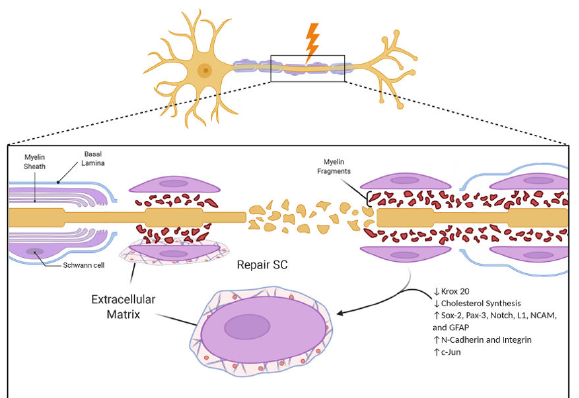
Figure 1. The loss of contact with the axon activates morpho-functional changes leading to the repair Schwann cells (SCs). The figure was adapted from “Peripheral Nervous System (PNS) Myelin Structure” by BioRender.com (2020). GFAP, Glial fibrillary acidic